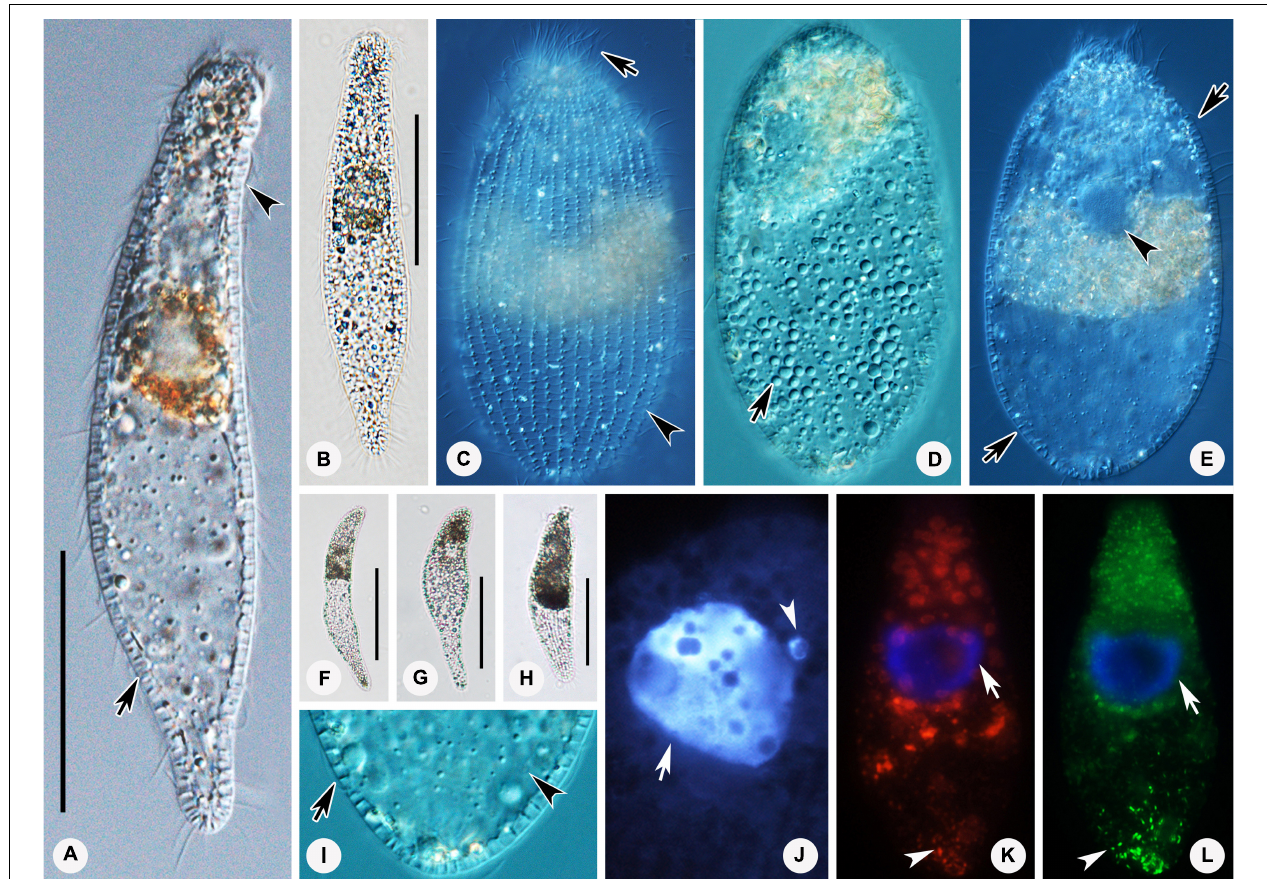
FIGURE 4 | Photomicrographs of Foissnerophrys alveolata gen. n., sp. n. in vivo (A–I) , after DAPI staining (J) and after fluorescence in situ hybridization (FISH) (K,L) . (A,B) Lateral view of a representative individual showing the cortical granules (arrow) and furrows in ectoplasm (arrowhead). (C) The pattern of silverline system, perioral cilia (arrow), and cortical granules (arrowhead). (D) The spherical inclusions in the cell. (E) The macronucleus (arrowhead) and cortical granules (arrows). (F–H) Shape variants. (I) The flat posterior end of the body (arrowhead) and cortical granules (arrow). (J) The macronucleus (arrow) and micronucleus (arrowhead). (K,L) The macronucleus (arrows), bacteria (K) , and archaea (L) scattered in the cytoplasm (arrowheads). Scale bars: 40 µ m (A,B) , 60 µ m (F–H) .